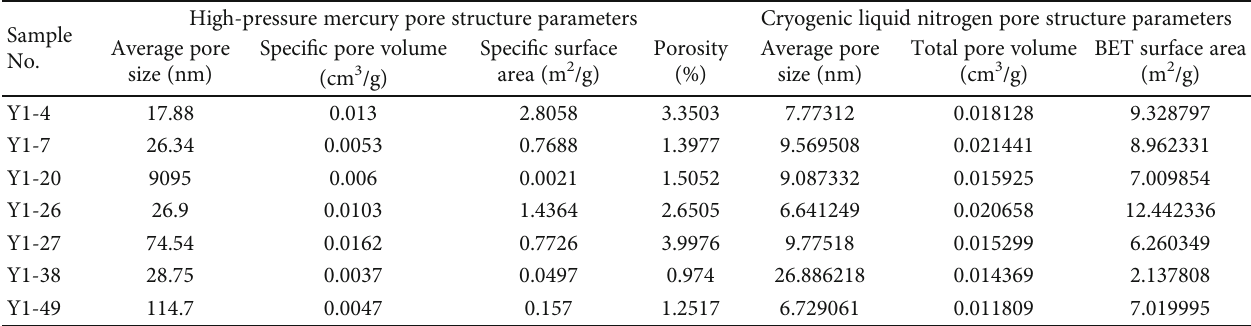
Table 4: Pore structure parameters of high-pressure mercury injection and low-temperature liquid nitrogen adsorption experiment in well